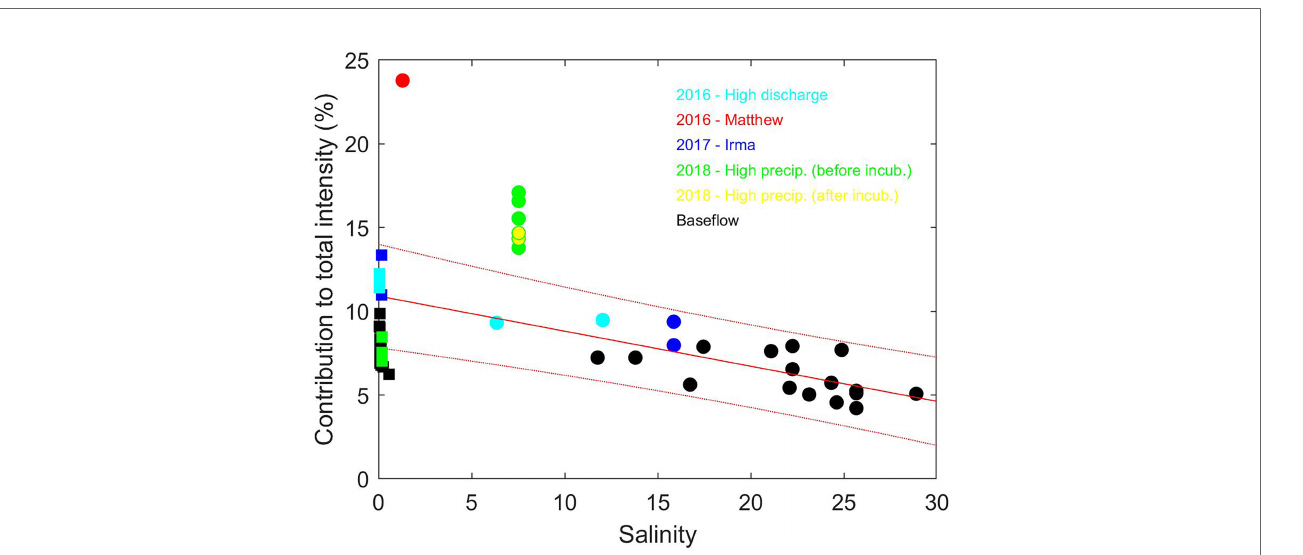
FIGURE 8 | Input of terrigenous DOM during extreme events. Percentage contribution of 481 molecular formulae that had their relative abundance strongly increased at Sapelo Sound after the passage of Hurricane Matthew to the sum of the magnitude of all peaks with molecular formula assigned in FT-ICR MS spectra for all samples. Circles represent samples collected at Sapelo Sound, while squares are samples collected at the Altamaha River, color coded according to the legend. Red line shows linear fi t to observations (only using samples from Sapelo Sound, except for those collected after the passage of Hurricane Matthew or the high precipitation event in October 2018; see text for details). Dashed red lines show predicted intervals.